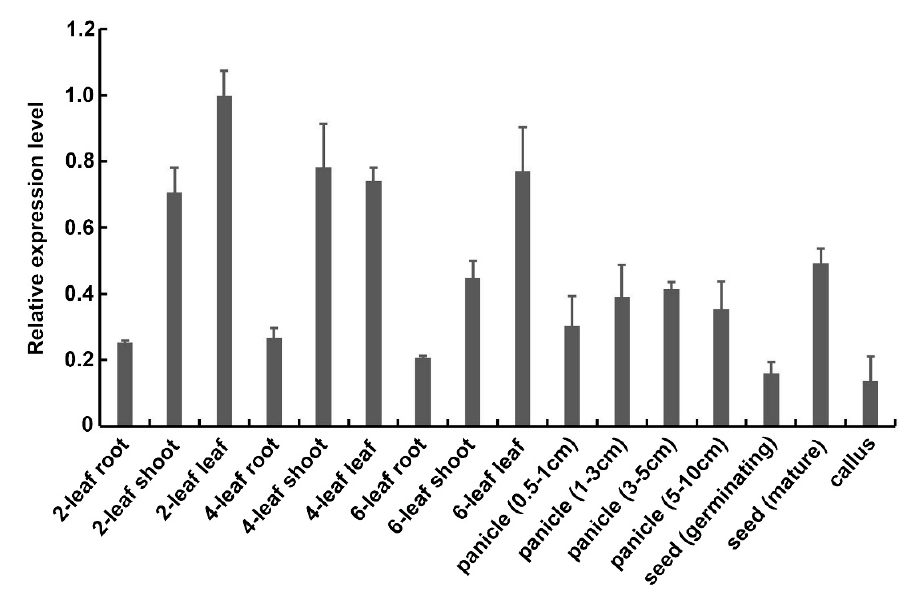
Figure 1. Expression patterns of OsExo70B1 .